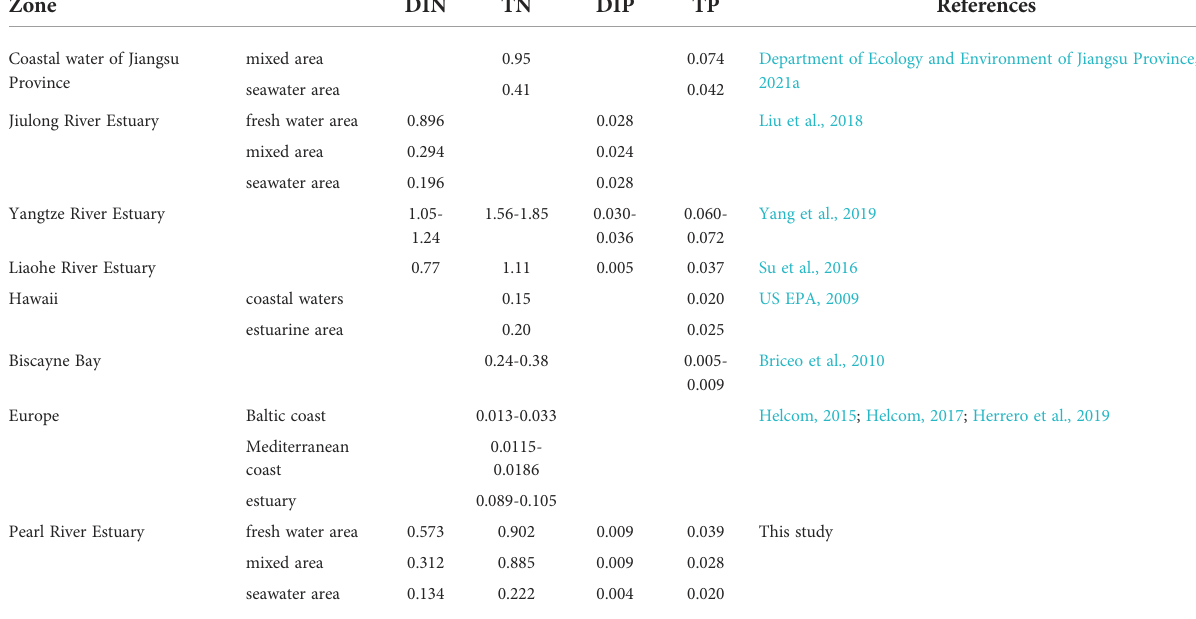
TABLE 3 Reference condition or criteria in different coastal water and estuaries worldwide (mg·L -1